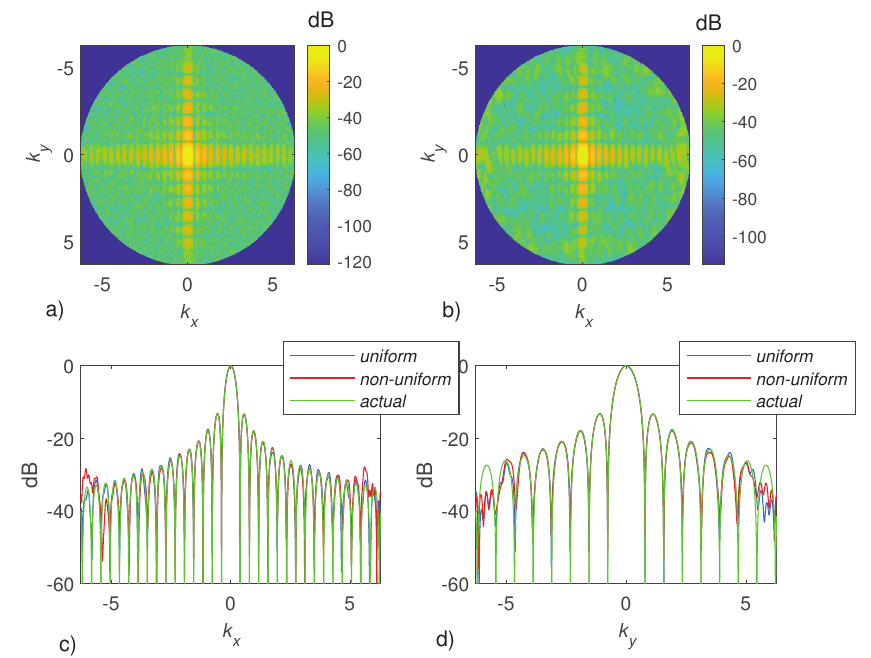
Figure 8. Normalized amplitude of the radiation pattern of J 2 ( x , y ) with X s = 8 λ , Y s = 4 λ , z o = 7 λ , X 0 = 30 λ and Y 0 = 15 λ . In ( a ), the radiation pattern is obtained by employing the near-field data according to the proposed non-uniform sampling scheme over the grid shown in ( b ) of Figure 2 and then interpolated over a λ /2 grid. In ( b ), the radiation pattern is obtained by directly employing the near-field data over a uniform λ /2 grid. Panels ( c , d ) have been obtained by fixing k y = k sin ( π /20 ) sin ( π /4 ) and k x = k sin ( π /20 ) cos ( π /4 ) , respectively, and compare the radiation pattern cut-views passing through the main-beam maximum. The green lines refer to the actual radiation pattern, the blue lines to the radiation pattern computed by using the uniform λ /2 sampling and the red ones show the radiation pattern obtained by the proposed method. Noisy case with additive complex white Gaussian noise and SNR = 20 dB.